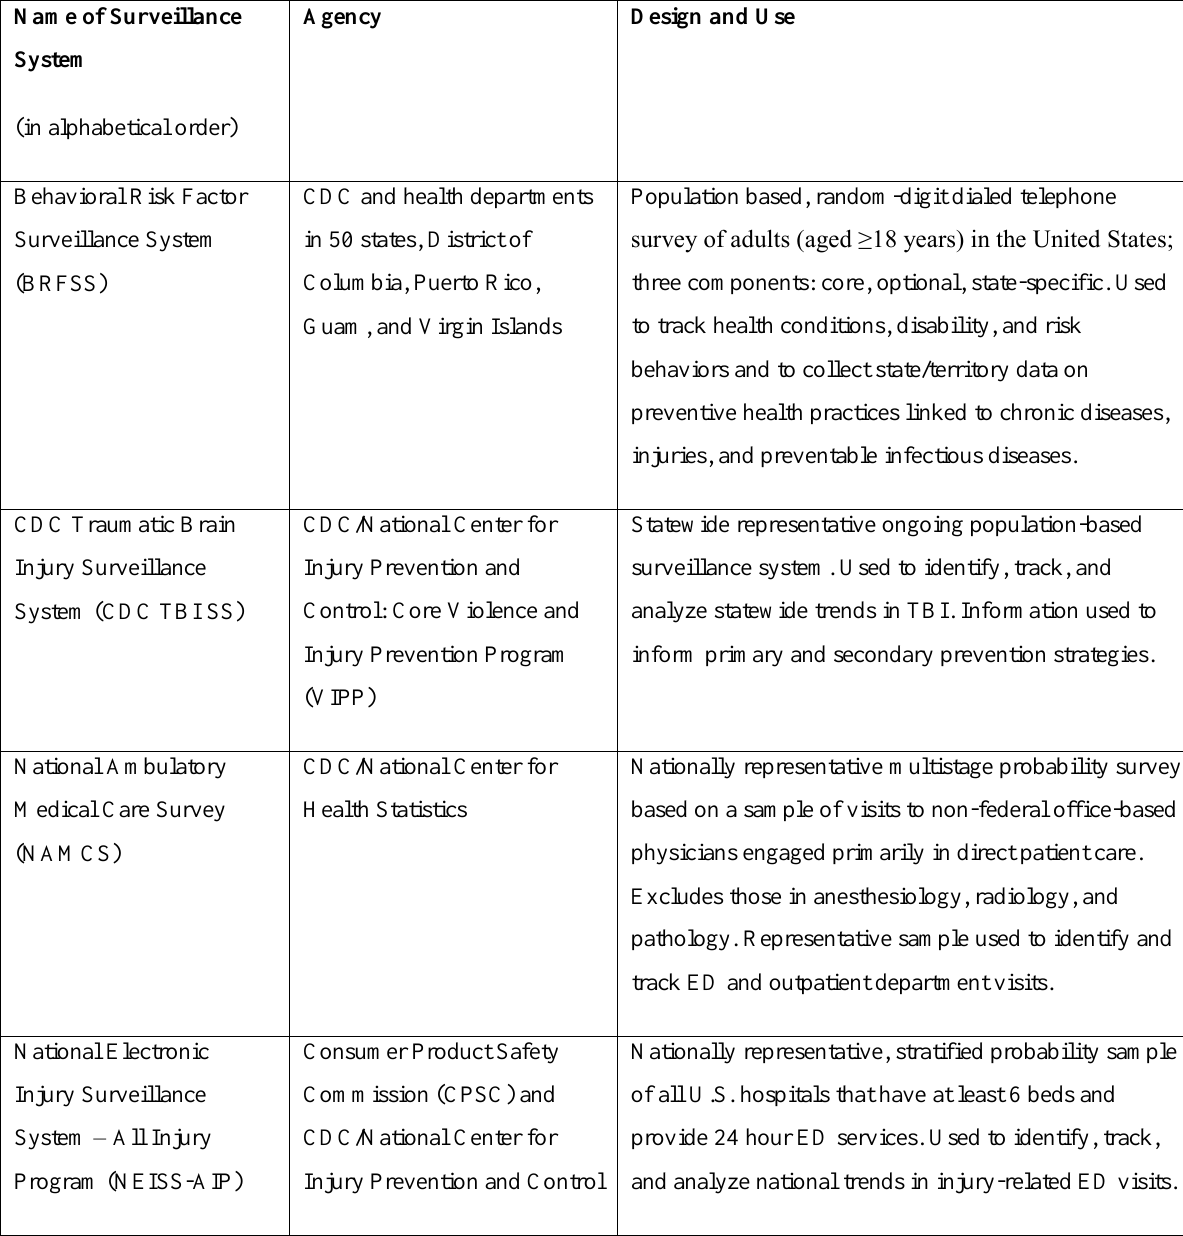
Table 5. Civilian Public Health Surveillance